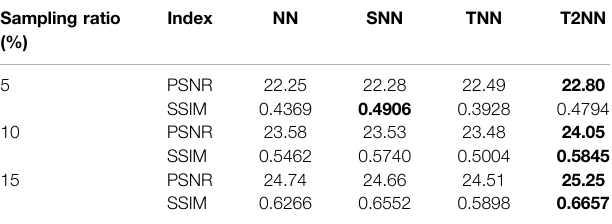
The highest PSNS/SSIM are highlighted in